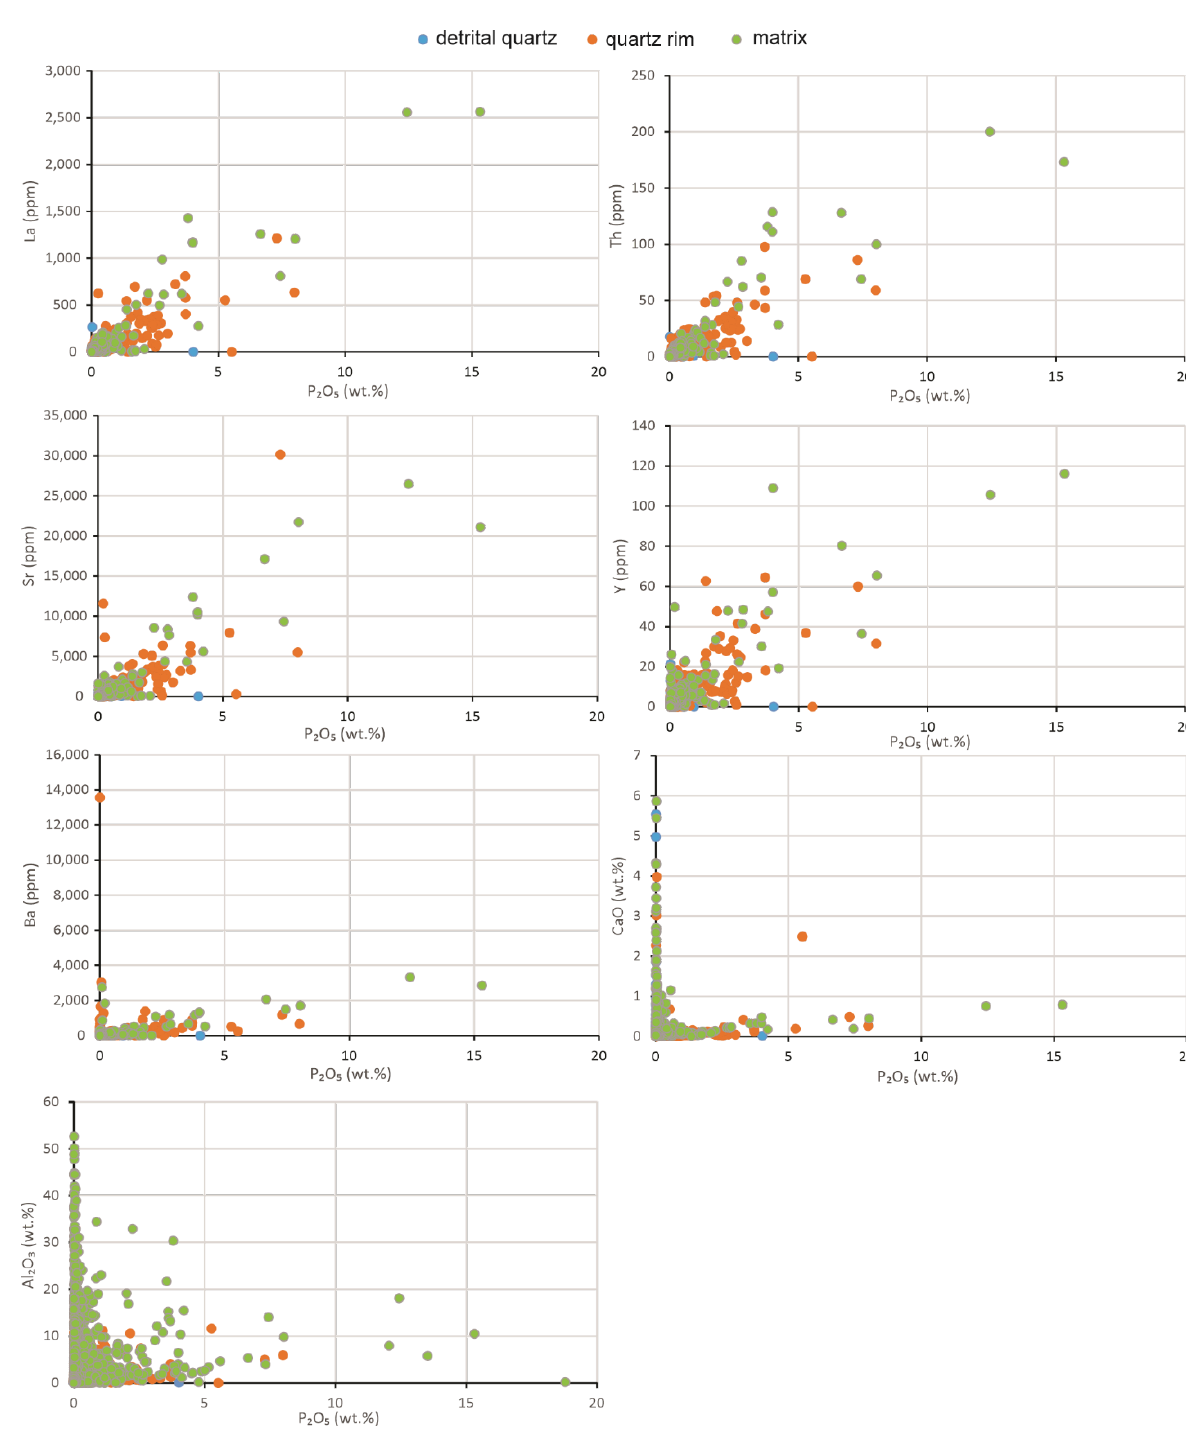
Figure 7. Bivariate diagrams showing various correlations between P and other elements, including positive correlations with La, Th, Sr and Y, partial positive correlations with Ba and Ca and poor correlations with Al.